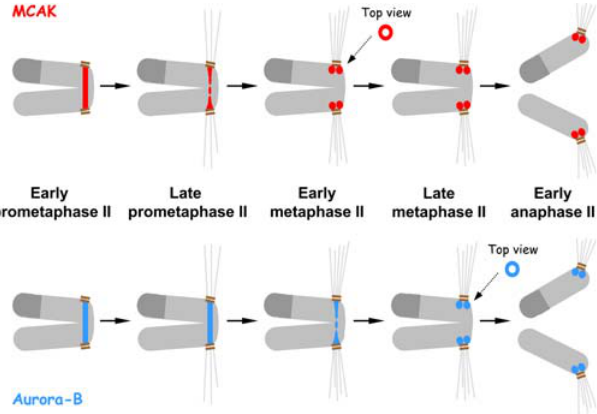
Figure 8. Schematic Representation of the Distribution of MCAK and Aurora-B from Early Prometaphase II to Early Anaphase II The chromosome is depicted with one chromatid in light grey, and the sister one both in light and darker grey to indicate that it recombined. Trilaminar kinetochores are indicated in brown, kMTs in light grey, MCAK in red, and Aurora-B in blue. In early prometaphase II, MCAK and Aurora- B colocalise as a band at the inner centromeric domain between sister kinetochores. Once chromosomes attach to kMTs from opposite poles, MCAK relocalises to appear as a pair of spots below both kinetochores at early metaphase II. In these top-viewed centromeres MCAK appears as a ring that encircles kinetochores. In turn, Aurora-B also relocalises as a pair of spots below kinetochores but at late metaphase II, where as MCAK, it encircles kinetochores. The MCAK and Aurora-B perikinetochoric rings are still evident during early anaphase